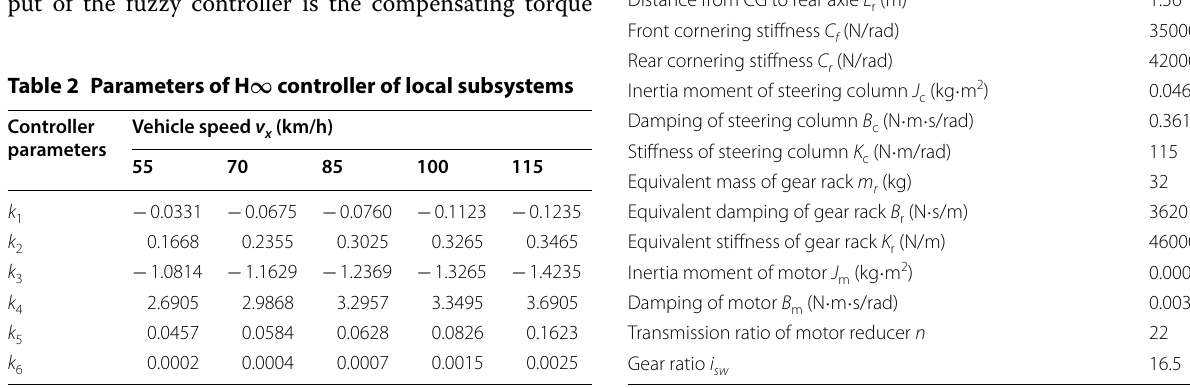
Table 2 Parameters of H Controller parameters